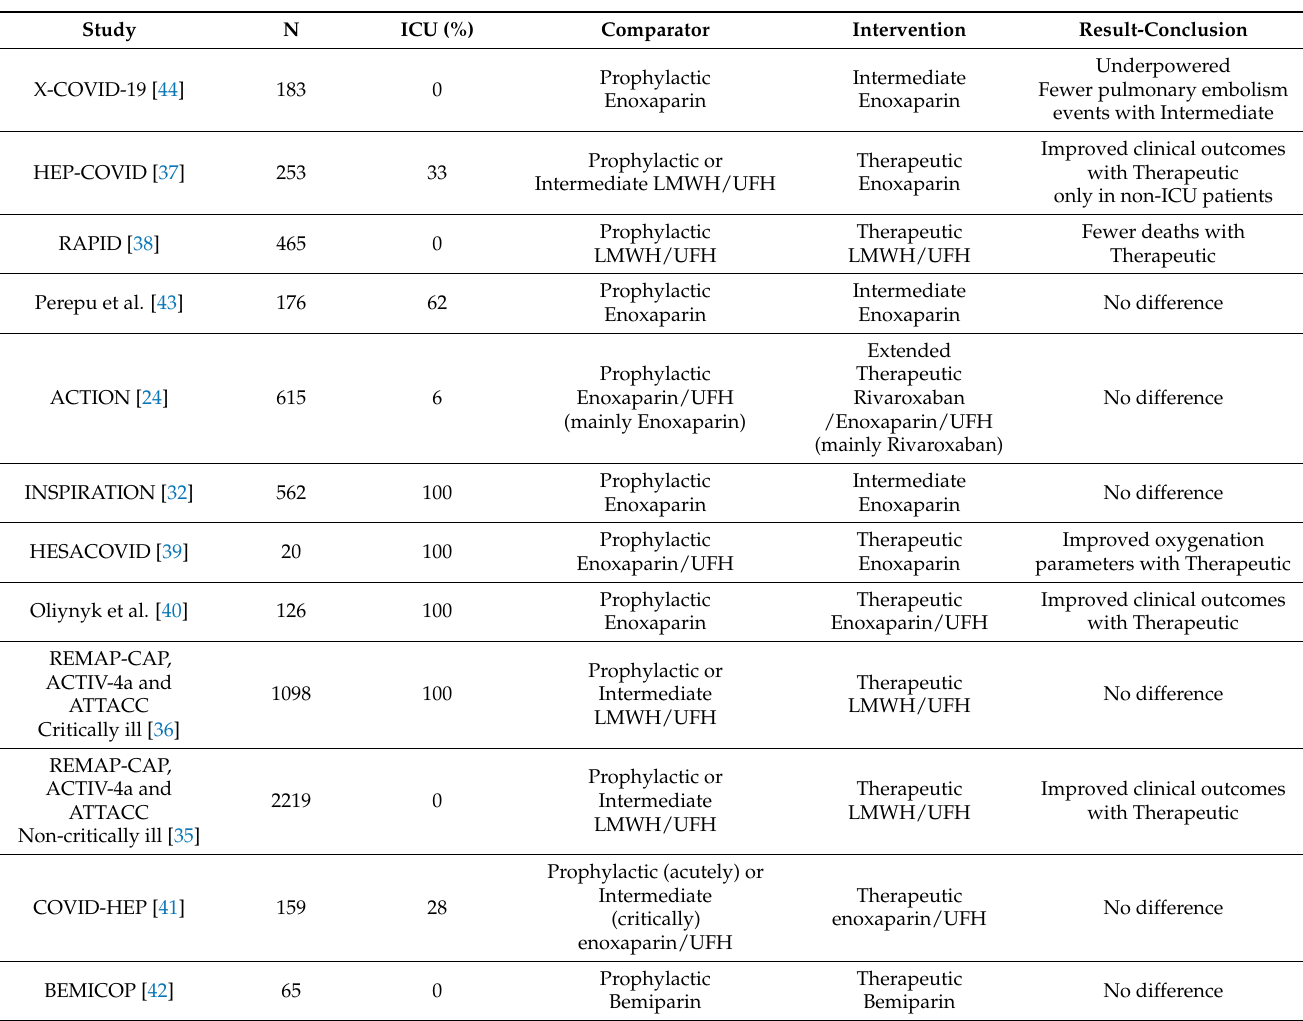
Table 2. Randomized Clinical Trials evaluating the optimal dosage of thromboprophylaxis in hospi- talized patients with